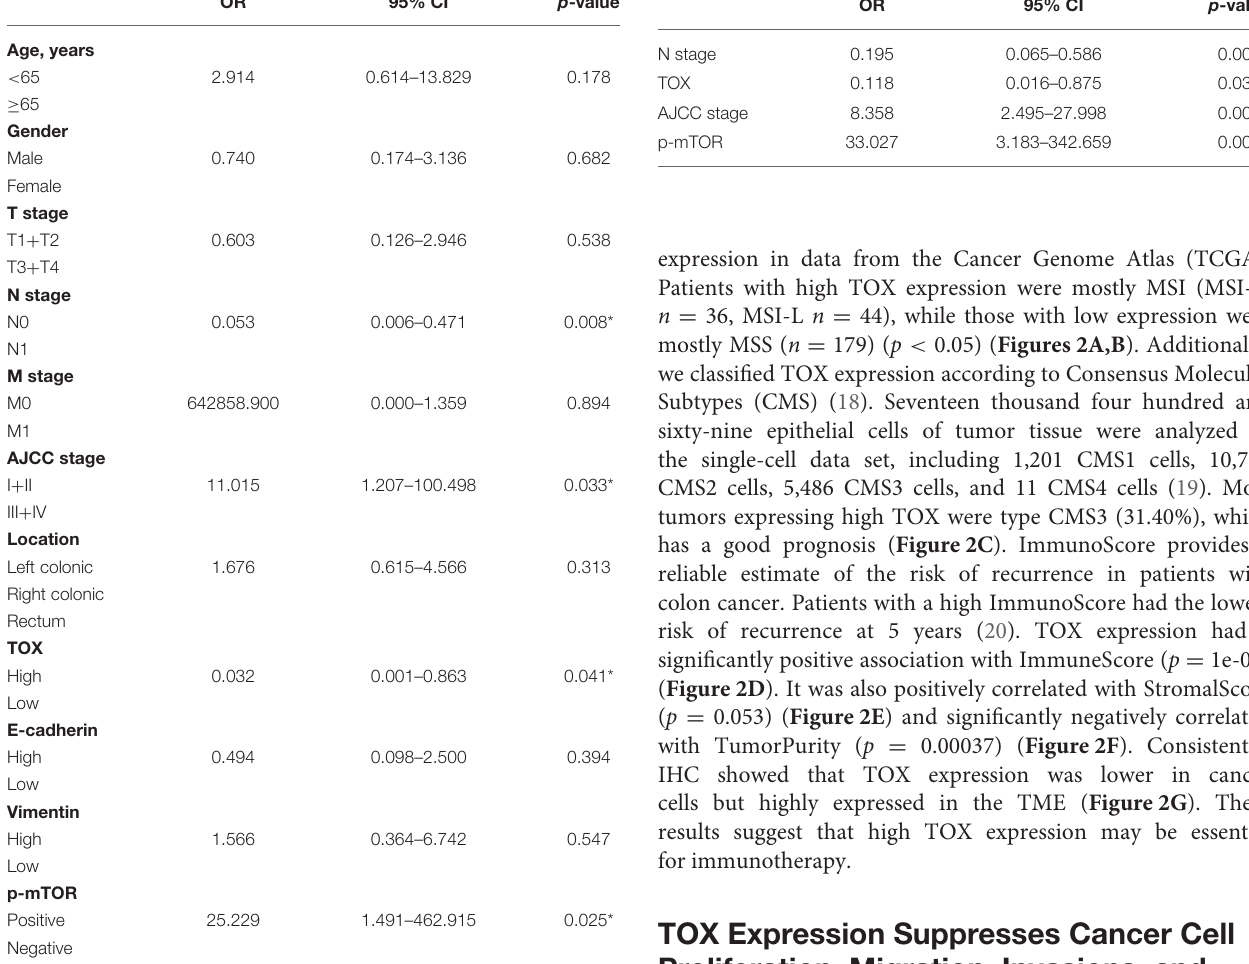
predictor for OS of CRC patients.